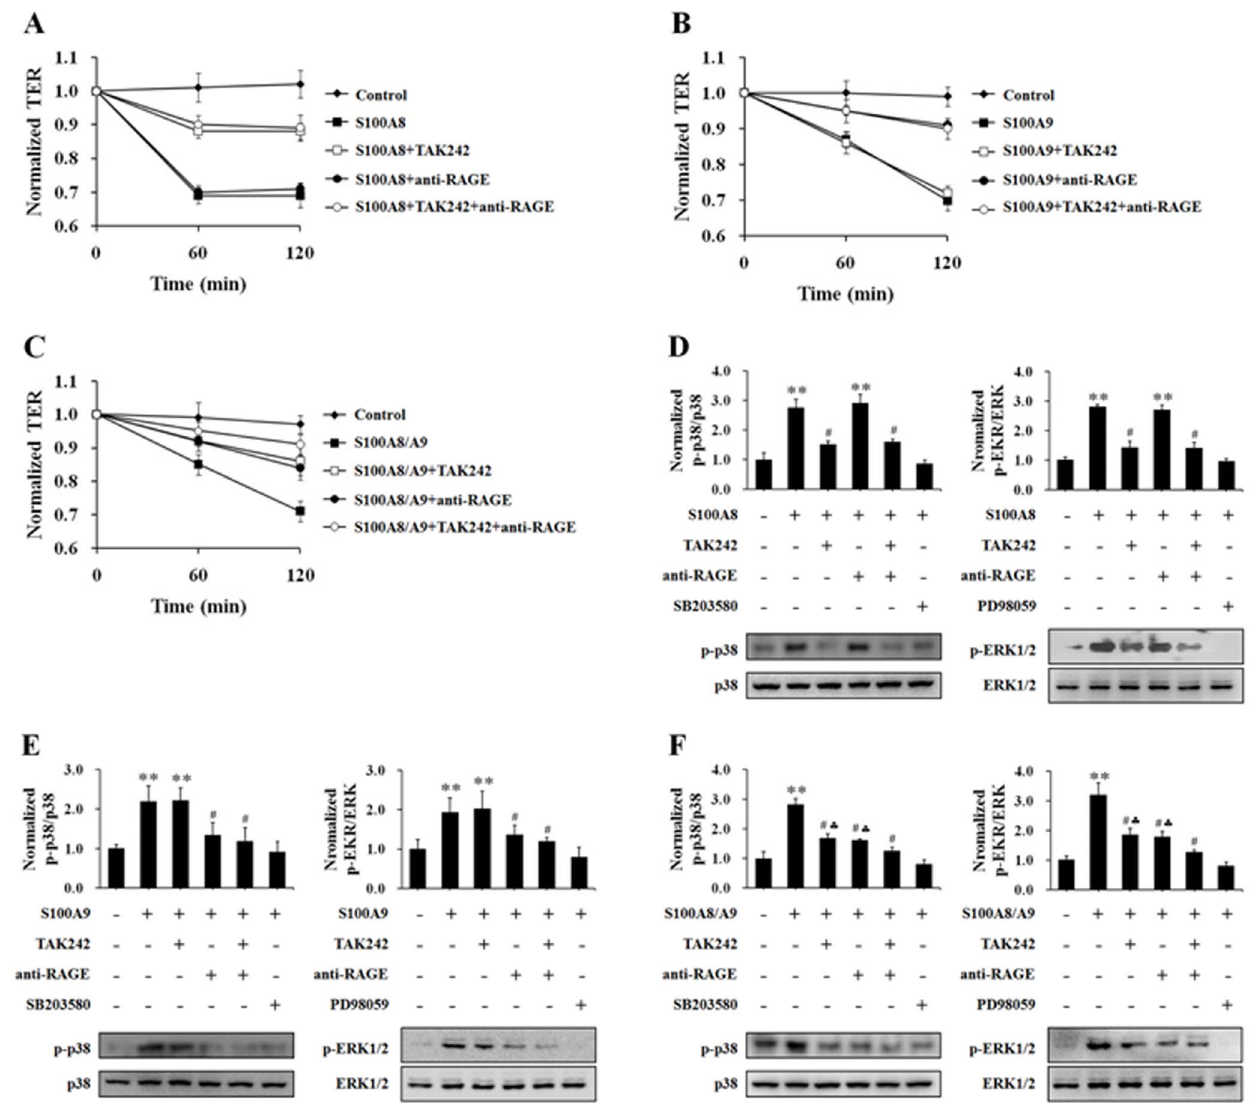
Figure 6. The effects of blocking TLR4 and RAGE on S100A8, S100A9 and S100A8/A9 stimulation of HUVECs. HUVECs were stimulated with S100A8 (2.0 m g/mL) ( A, D ), S100A9 (2.0 m g/mL) ( B, E ) and S100A8/A9 (2.0 m g/mL) ( C, F ) for 120 min with or without 60 min pre-incubation with specific blockers (TAK242 (5 m M) for TLR4 and anti-human RAGE antibody (10 m g/mL) for RAGE). Then the TER was measured ( A, B and C ). All data are presented as mean 6 s.d. of four independent experiments. Phosphorylation of p38 (p-p38) and ERK1/2 (p-ERK1/2) were also assessed by Western blotting ( D, E and F ). The ratio of immunointensity between the phosphorylation of p38 and ERK1/2 (p-p38 and p-ERK) and total p38 and ERK1/2 (p38 and ERK) were calculated ( D, E and F ). The results are expressed in mean 6 s.d. from three independent experiments. ** P , 0.01 vs. Control; # P , 0.05 vs. S100A8/S100A9; § P , 0.05 vs. S100A8/S100A9 + TAK242 + anti-RAGE.